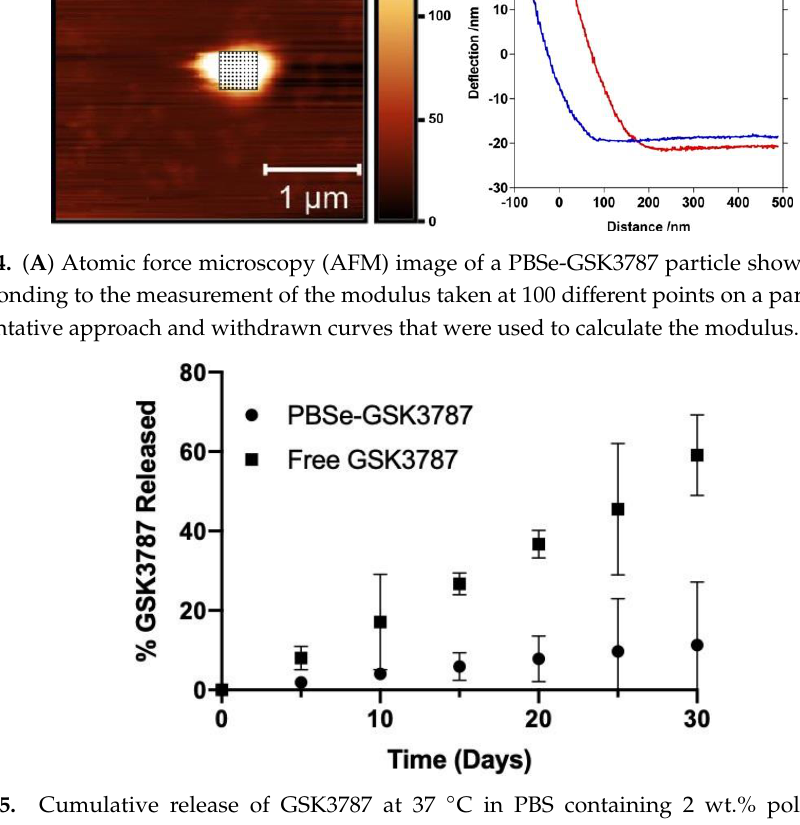
Figure 5. Cumulative release of GSK3787 at 37 °C in PBS containing 2 wt.% polysorbate 80. Slower release of GSK3787 was observed from PBSe-GSK3787 particles compared to the free drug. Error bars correspond to the standard deviations on triplicate samples.